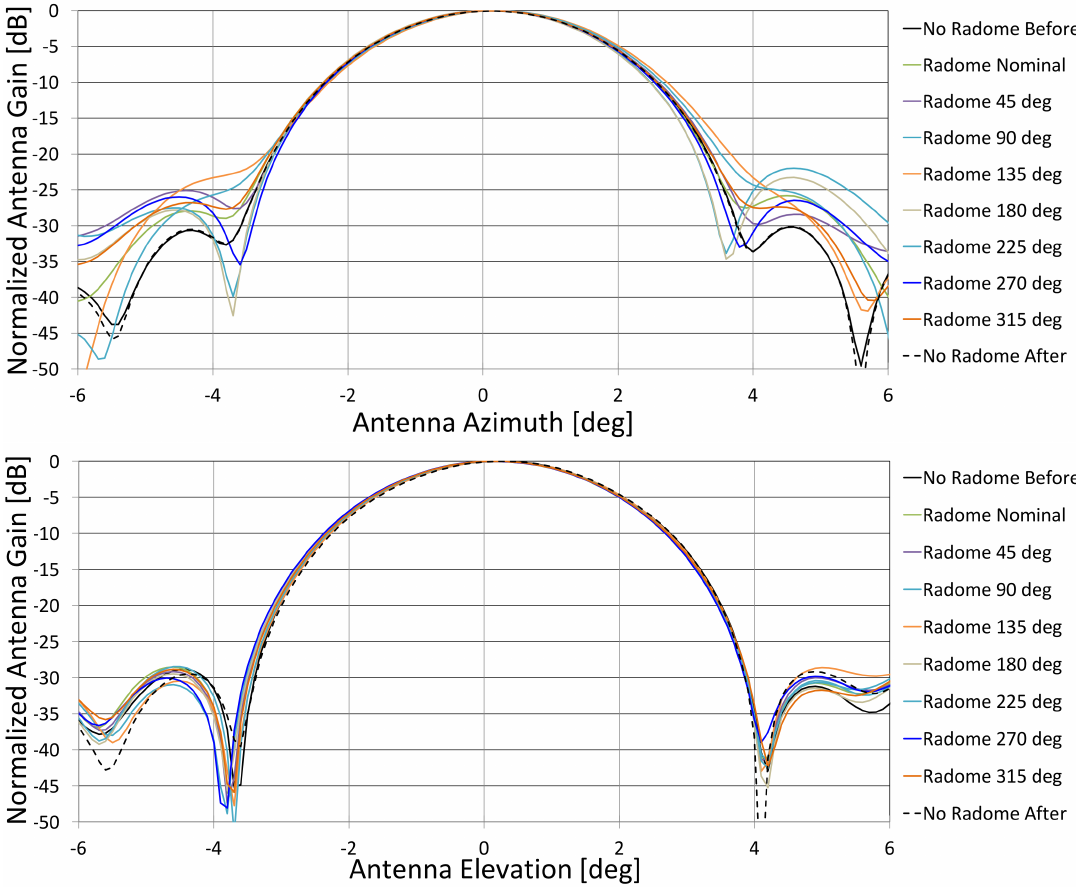
Figure 7. Variation of the azimuth ( top ) and elevation ( bottom ) antenna pattern due to the radome with spin angle. Only the center three degrees are used in